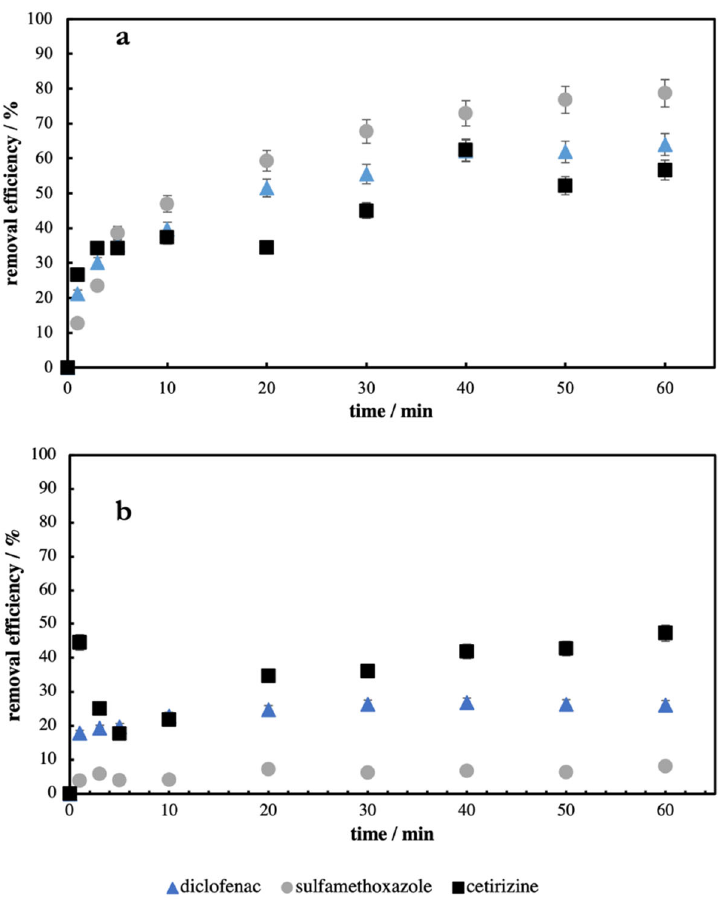
Figure 1. Dependence of removal efficiency of diclofenac, sulfamethoxazole and cetirizine on the reaction time using WSCl2 ( a ) and HWOH ( b ) as adsorbent.